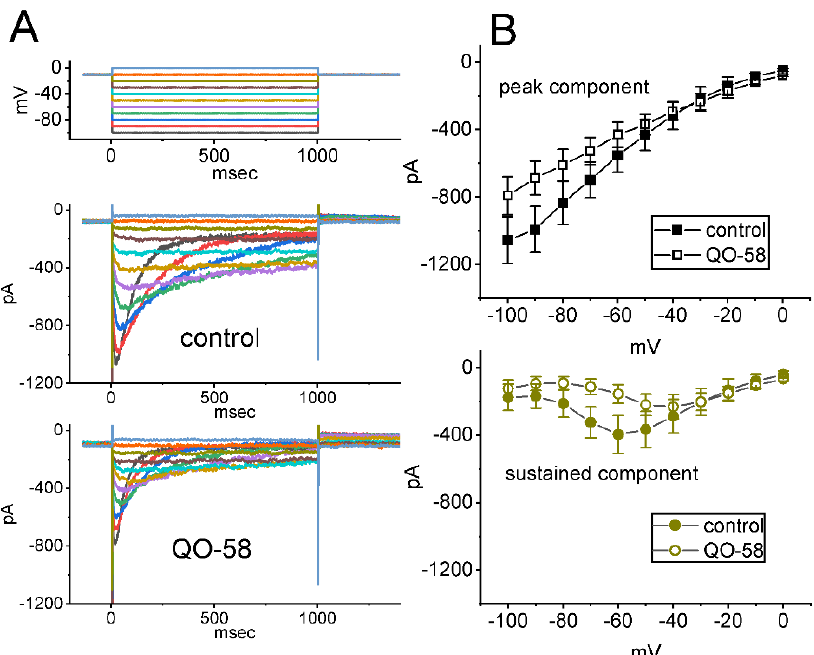
Figure 8. Minor inhibition of erg -mediated K + current ( I K(erg) ) produced by the presence of QO-58 in GH 3 cells. In these experiments, we used high-K + , Ca 2+ -free solution as bathing medium and the recording pipette was filled up with K + -containing (145 mM) solution. ( A ) Superimposed current traces obtained in the control period (upper) and during cell exposure to 10 μM QO-58 (lower). The top part indicates the voltage-clamp protocol imposed. ( B ) Average I-V relationship of peak (black squares, upper) or sustained (brown circles, lower) component of I K(erg) obtained in the absence (filled symbols) and presence (open symbols) of 10 μM QO-58 (mean ± SEM; n = 7 for each point). Peak or sustained I K(erg) obtained with or without the QO-58 addition was measured at the start or end-point of each hyperpolarizing step with a duration of 1 s. Of note, the presence of 10 μM QO-58 slightly inhibited I K(erg) in these cells.